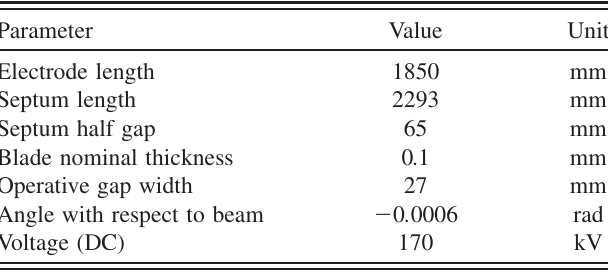
TABLE III. Main SEH31 septum parameters.